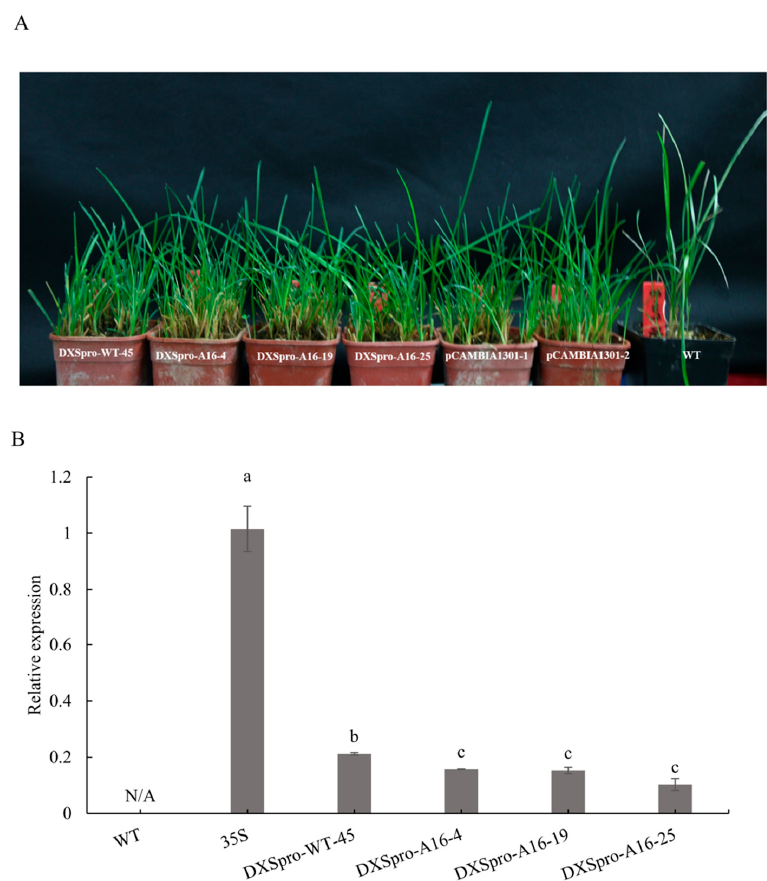
Figure 3. Analysis of PpDXS1 promoter in transgenic Poa pratensis plants. ( A ) Photos of plants with transformed PpDXS1 promoters from WT and A16, and pCAMBIA1301 vector; ( B ) relative expression of GUS gene in transgenic lines of different PpDXS1 promoters. The Actin is reference gene, and the